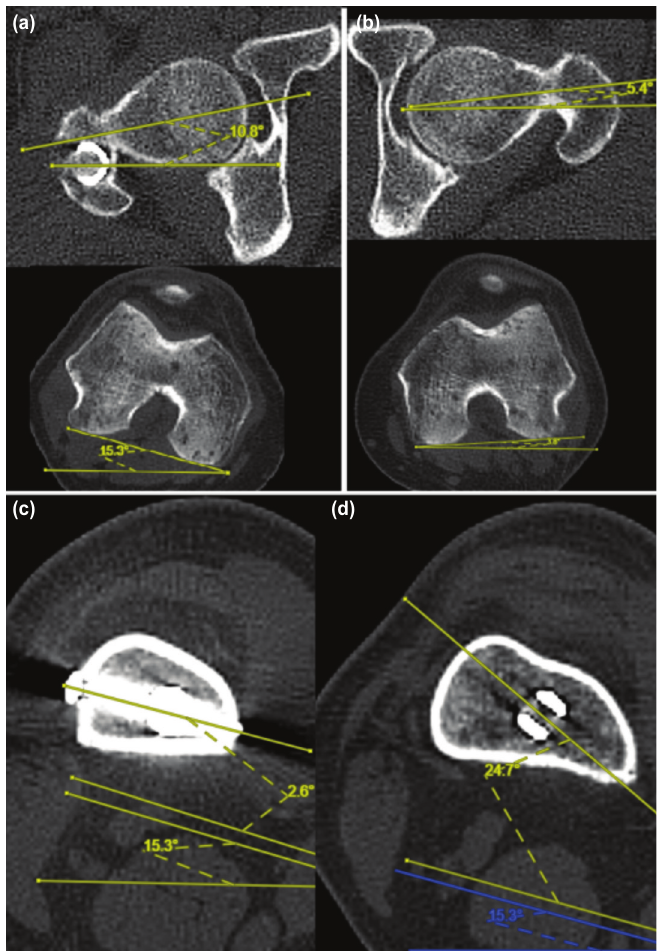
CT scan demonstrated right femur had external malrotation, and the nail placement was excessively internal rotated. (a) Right Fig. 2: femur had 26.1° anteversion (10.8 + 15.3), (b) uninjured left femur had 1.6° retroversion (-5.4 + 3.8), (c) axial cut of right distal femur at level of static screw hole showed that the static screw was parallel to transcondylar axis, (d) axial cut of right distal femur at level of dynamic screw holes showed that the dynamic screw hole was 25° internal rotated in relation to transcondylar